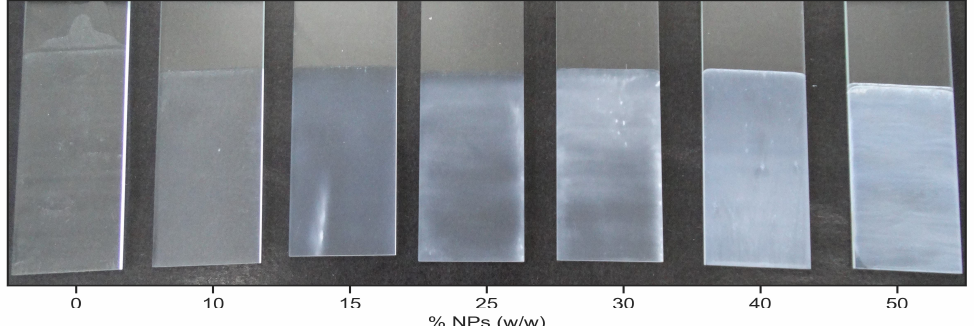
Figure 5. Glass samples coated with several ratios of OPSZ/NPs.